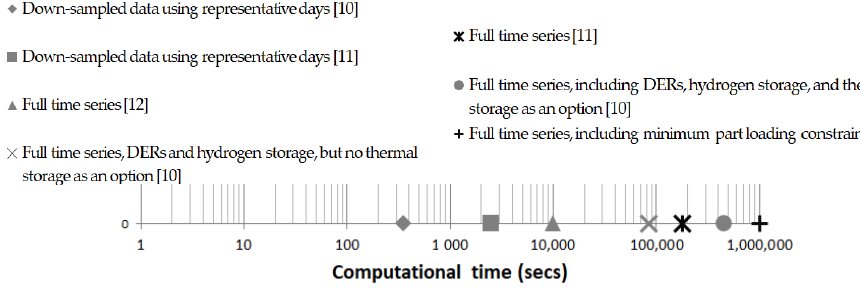
Figure 1. Run-time comparisons for different optimization approaches and use-cases. The different model setups tested in [10–12] result in considerable different run-times. The legend is ordered from small to large computational time. Please note the logarithmic scale.